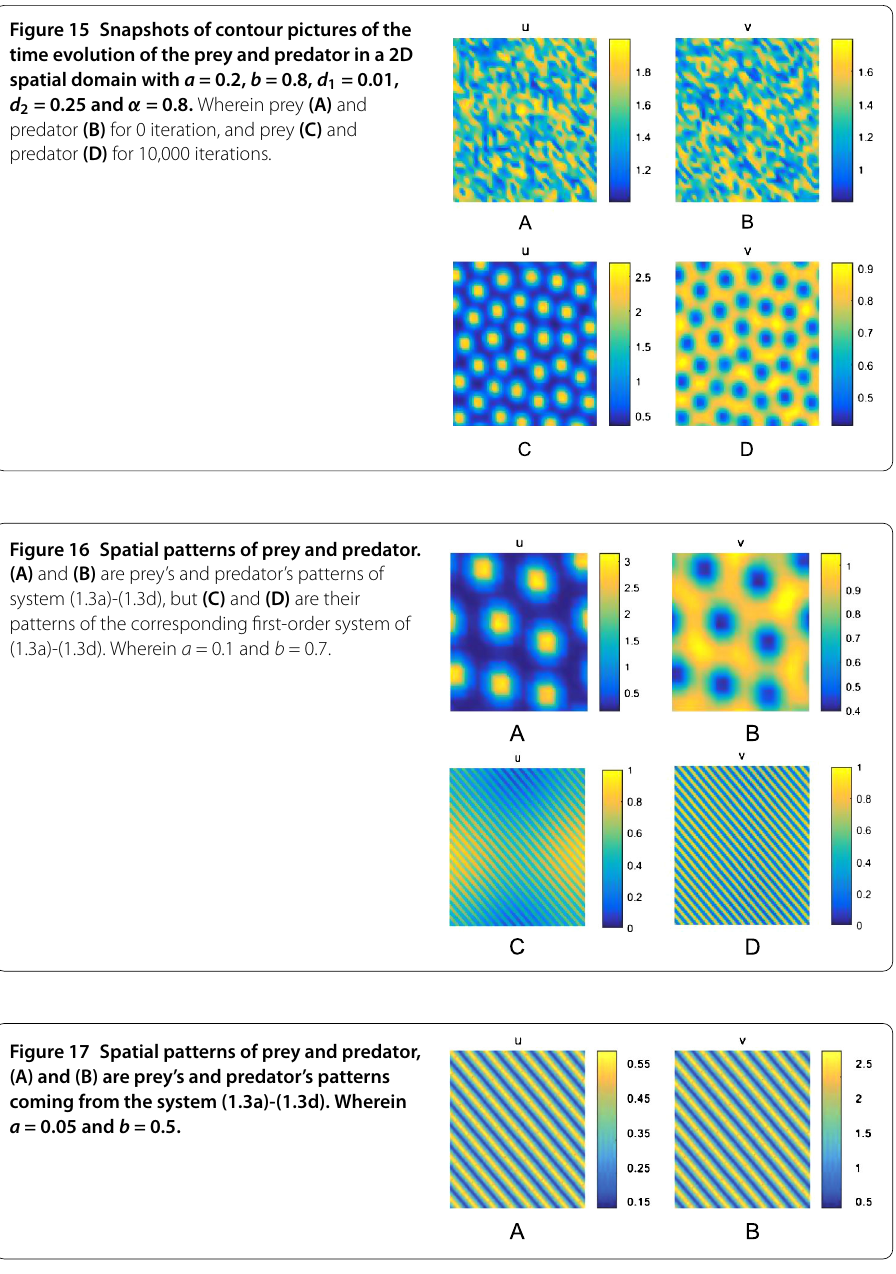
Figure 15 Snapshots of contour pictures of the time evolution of the prey and predator in a 2D spatial domain with a = 0.2, b = 0.8, d 1 = 0.01, d 2 = 0.25 and α = 0.8. Wherein prey (A) and predator (B) for 0 iteration, and prey (C) and predator (D) for 10,000 iterations.